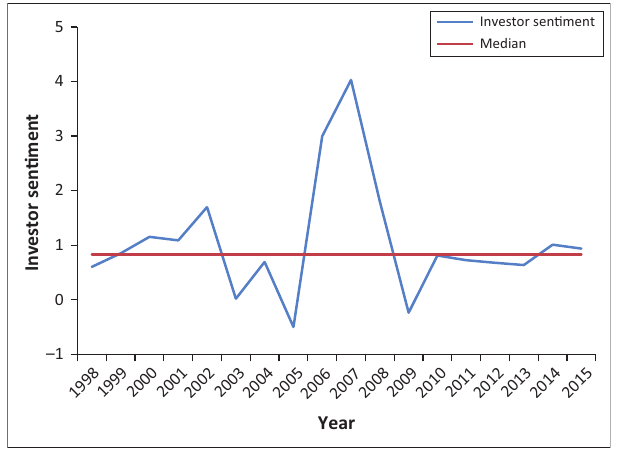
FIGURE 1: The investor sentiment index from Dalika and Seetharam